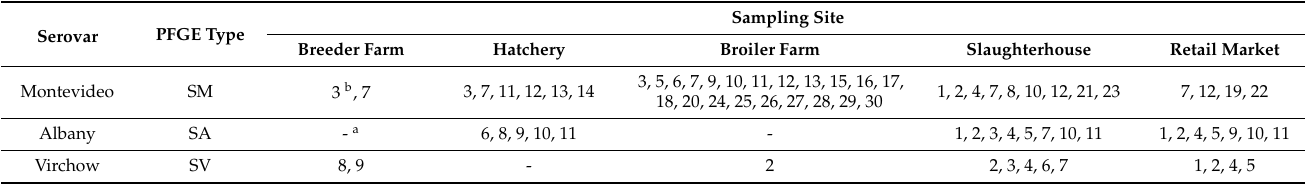
Table 5. The distribution of PFGE type of Salmonella isolates from different stages along the chicken production chain. Serovar